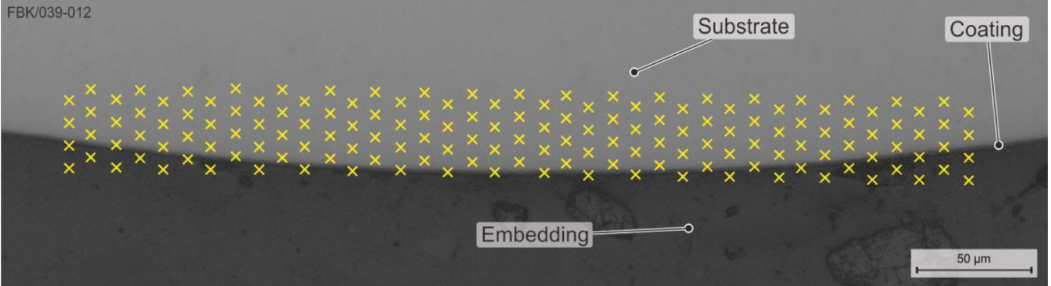
Figure 7. Microscopy image of the cross section of a TiB 2 coated cemented carbide tool shaft showing the measurement area and positions of indentation ( × ).